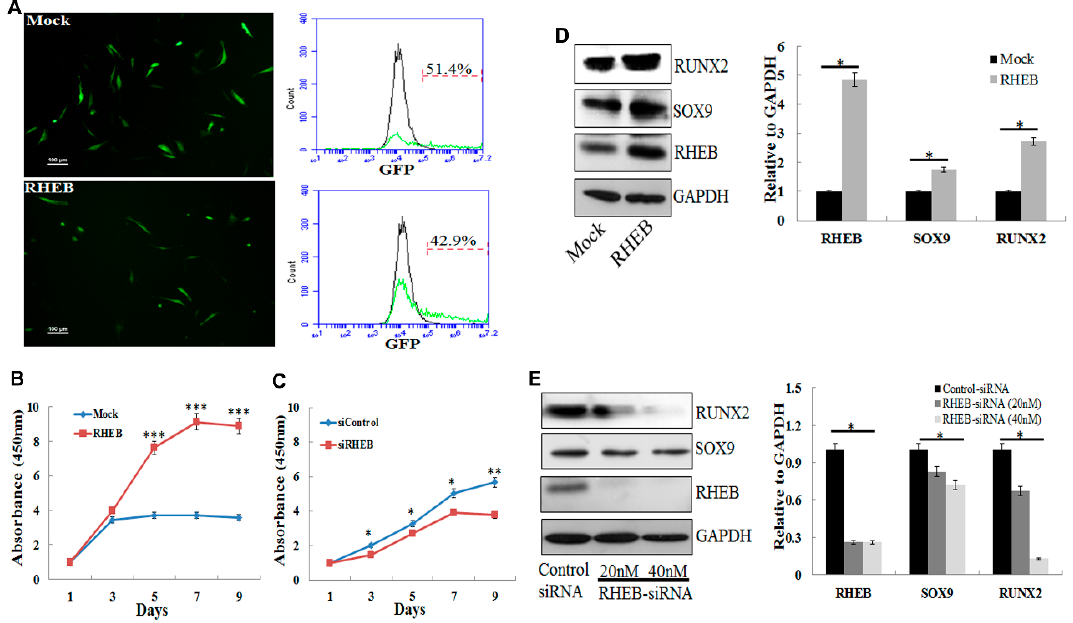
Figure 1. The differential role of Ras homolog enriched in brain (RHEB) in adipose derived stem cells (ASCs). ( A ) Left panel : ASCs cells were transfected with Mock and RHEB vectors that harbors sequence for GFP. Transfected cells showed green fluorescent protein (GFP) expression as visualized under fluorescent microscope; right panel : Analysis of transfection efficiency by detecting GFP expression thorough flow cytometry; ( B , C ) cell proliferation analysis after RHEB overexpression and knockdown, respectively, using CCK-8. During CCK-8 assay, an orange formazan product is produced by cellular dehydrogenases. The amount of formazan produced is directly proportional to the number of living cells. Absorbance of orange formazan was measured at 450 nm; ( D ) left panel : protein expression analysis by Western blotting after RHEB overexpression; right panel : quantification of the Western blots using ImageJ (1.48v, Wayne Rasband, National Institute of Health, Bethesda, MD, USA) and normalizing with GAPDH; ( E ) left panel : protein expression analysis by Western blotting after RHEB knockdown; right panel : quantification of the Western blots using ImageJ and normalizing with GAPDH. (Data are shown for a representative experiment as averages of triplicates with standard deviation. The statistical significance of differences was calculated using the Student’s t -test. * p < 0.05; ** p < 0.01; *** p < 0.001; Scale bar: 100 μ m).